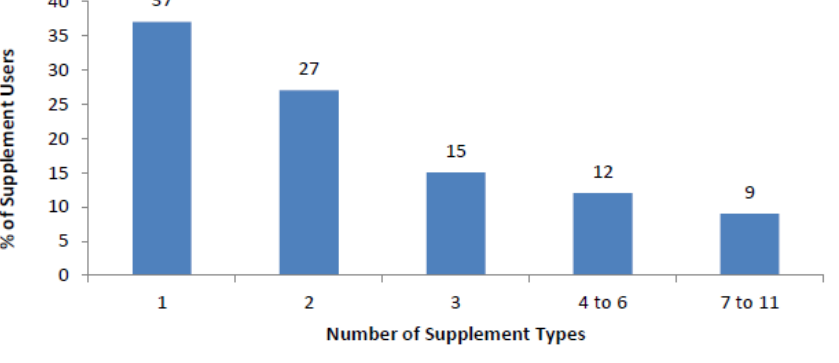
Figure 3. Number of different types of supplements used ( n =